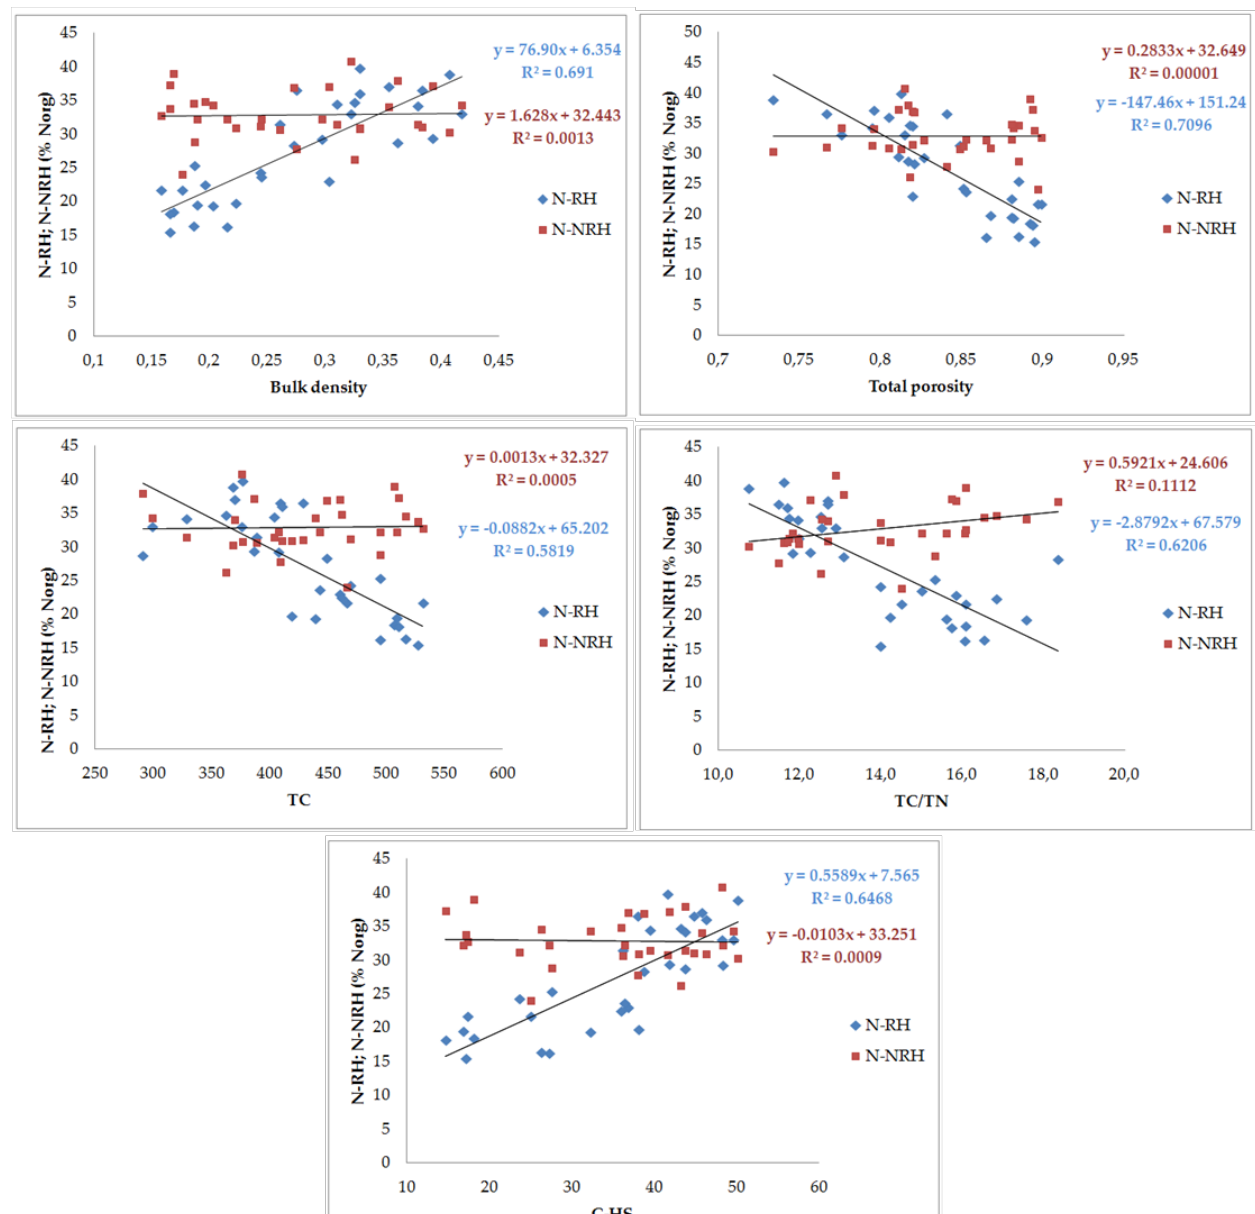
Figure 1. Relationship between percentage of hydrolyzing nitrogen fractions (N RHON and N NRHON ) and the chosen physical and chemical properties of the soil.